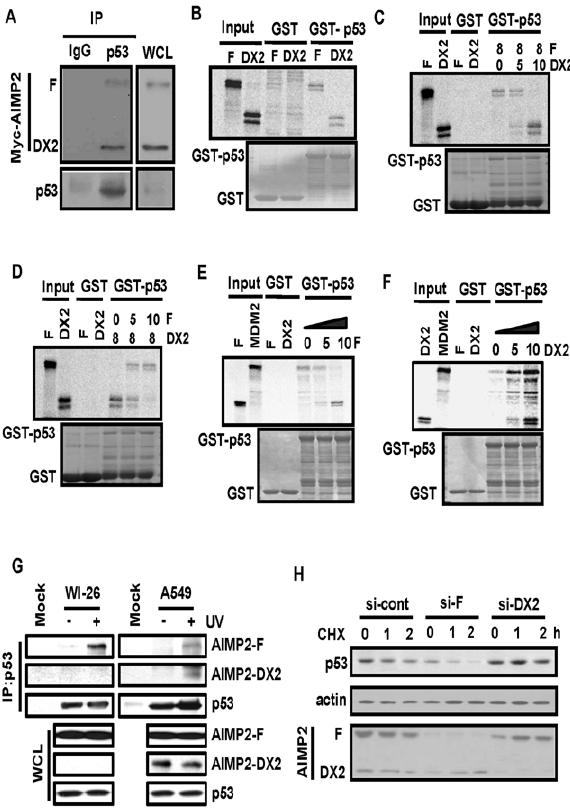
Figure 4. The effect of AIMP2-DX2 on the interaction of AIMP2-F with p53. (A) p53 was immunoprecipitated from A549 cells transfected with Myc-AIMP2-F and –DX2, and co-precipitation of the two AIMP2 proteins with p53 was determined with anti-Myc antibody. (B) AIMP2-F and –DX2 were radioactively synthesized by in vitro translation and each protein (20 m l of the in vitro translation reaction) was mixed with GST or GST-p53. GST proteins were precipitated with glutathione-Sepharose beads and co-precipitation of AIMP2-F and –DX2 was determined by autoradiography. (C) Radioactively synthesized AIMP2-F and –DX2 as above were used to see whether the two proteins would compete for the interaction with p53. The indicated amount of AIMP2-DX2 (indicated by microliter volume) was mixed with the fixed amount of AIMP2-F andGST- p53 to see the effect of AIMP2-DX2 on the AIMP2-F binding to p53. (D) Conversely, the indicated amount of AIMP2-F was added to the fixed amount of AIMP2-DX2. (E) MDM2, AIMP2-F and –DX2 were radioactively synthesized as above and the indicated volumes ( m l) of AIMP2-F was added to the binding mixture of MDM2 and GST-p53. The mixture was precipitated with glutathione-Sepharose and co-precipitation of MDM2 and AIMP2-F was determined by autoradiography. (F) The same experiment as above was conducted except that AIMP2-DX2 was added at the indicated amounts to the mixture. (G) WI-26 and A549 cells were subjected to UV irradiation and lysed. The extracted proteins were immunoprecipitated with anti-p53 antibody (FL-393), separated by SDS- PAGE and immunoblotted by immunoblotting with the anti-AIMP2 antibody. (H) A549 cells were treated with cycloheximide (CHX) to block de novo protein synthesis. AIMP2-F and –DX2 were suppressed with their specific siRNAs and the cellular levels of p53 were monitored by Western blotting at indicated time